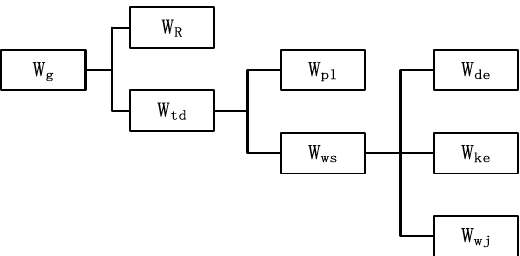
Figure 4. Scheme of generator energy conversion: W g —total energy of generator, W R —resistance loss in electrical circuit, W td —energy injected into the plasma channel, W pl —heating energy of the plasma channel, W ws —shockwave energy, W de —internal energy of rock, W ke —kinetic energy, W wj —reflected wave energy.